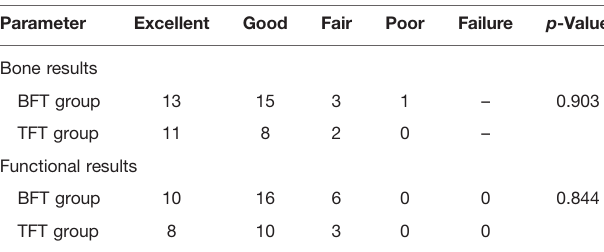
TABLE 5 | Summary of complications in the two